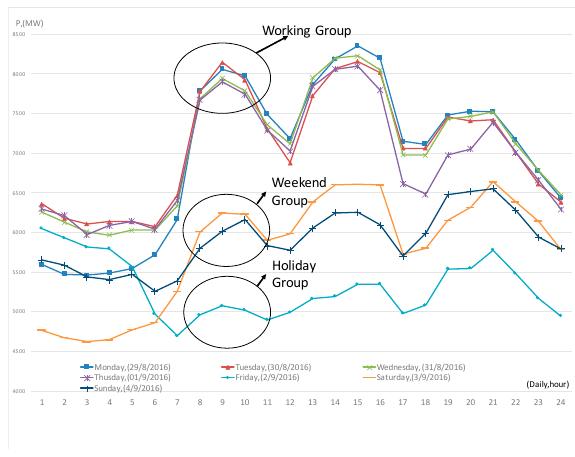
Figure 2. The daily load of one week in August 2016.